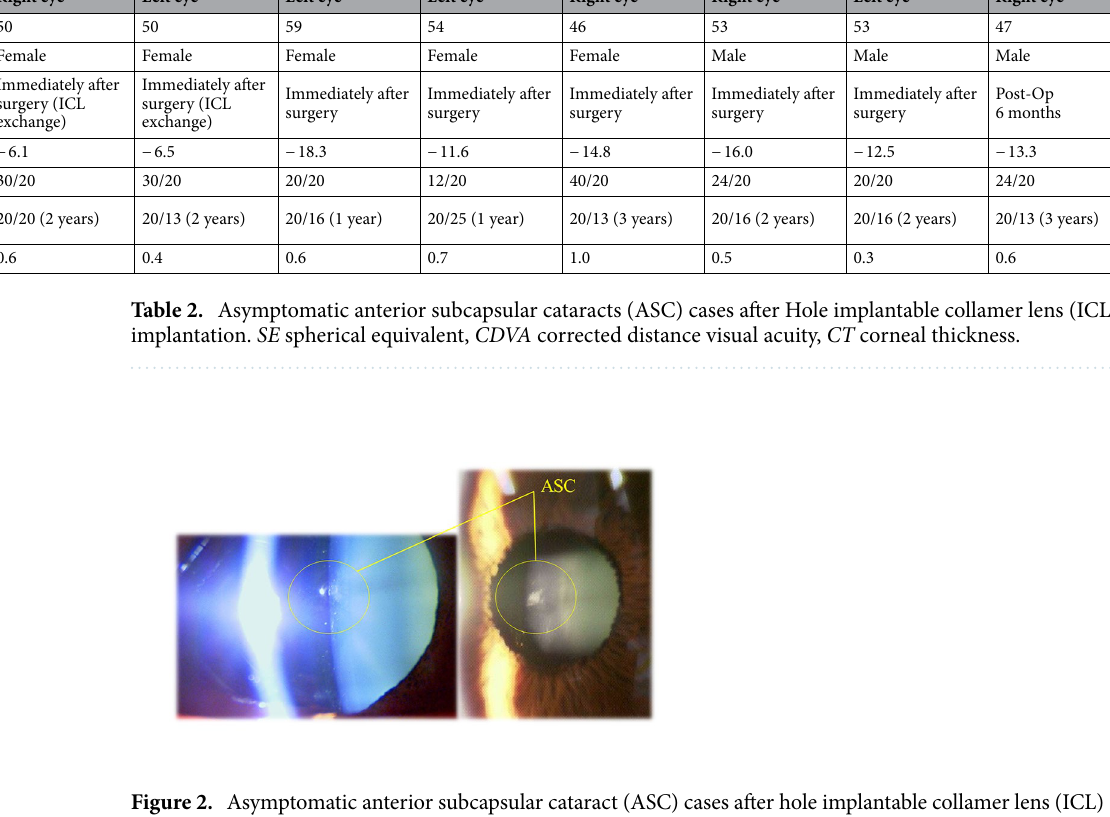
Figure 2. Asymptomatic anterior subcapsular cataract (ASC) cases after hole implantable collamer lens (ICL)